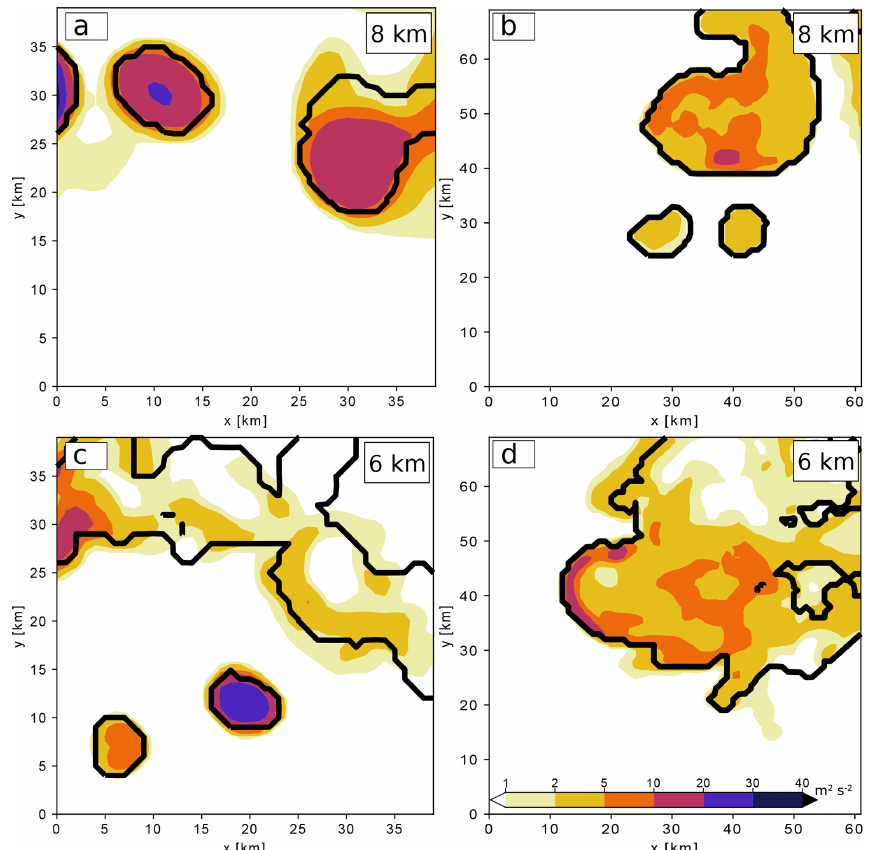
Figure 13. Same as Fig. 12 but for the subgrid turbulent kinetic energy